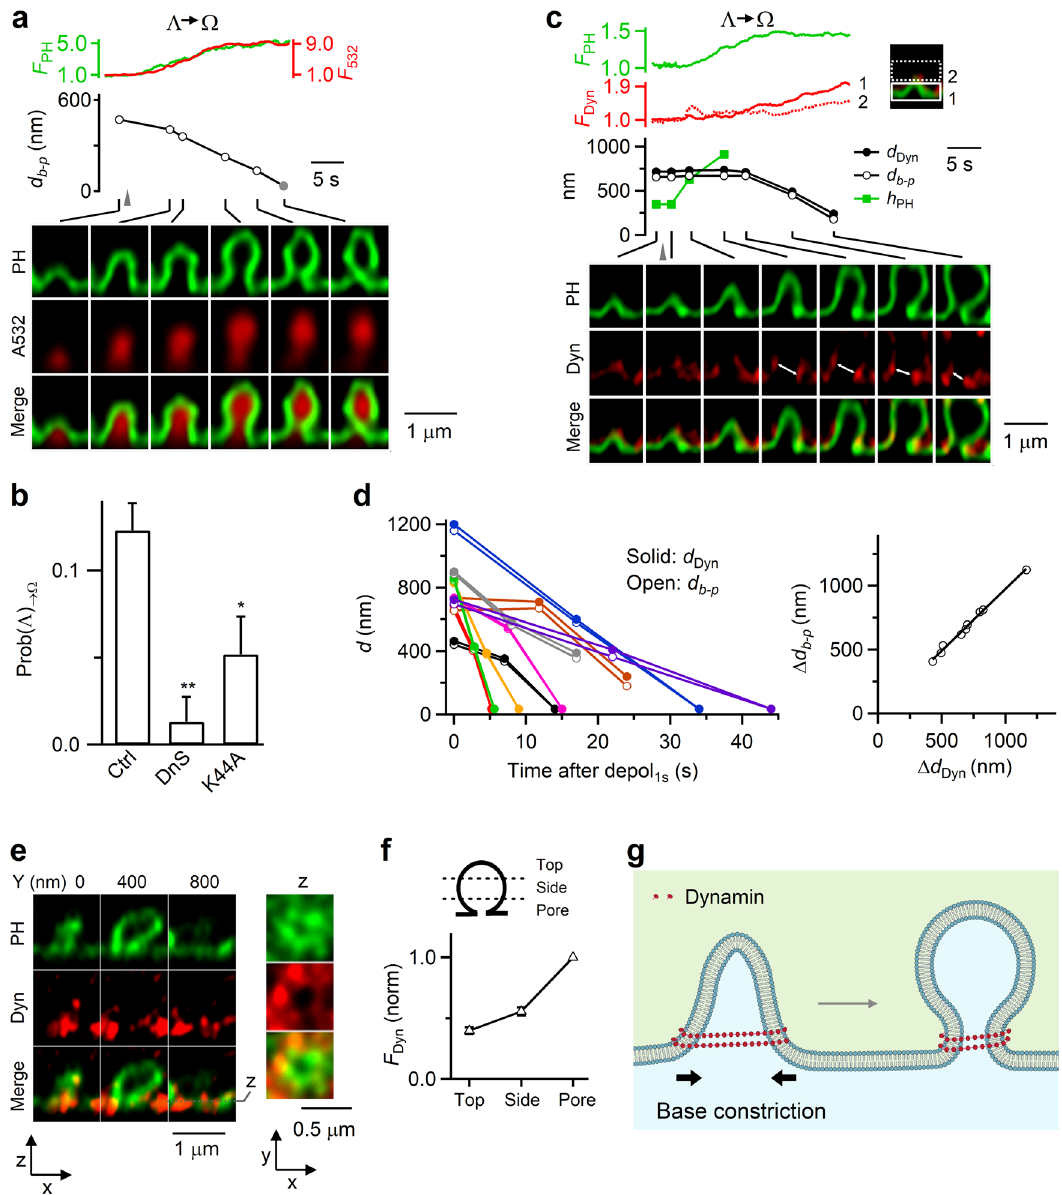
Fig. 4 Dynamin mediates Λ → Ω by surrounding and constricting Λ ’ s base in chromaf fi n cells. a F PH , F 532 , Λ ’ s base distance or Ω ’ s pore diameter ( d b-p ), and XZ/Y fi x images (at times indicated with lines) showing d b-p constriction during Λ → Ω . Gray triangle, depol 1s . Gray circle: <60 nm (STED resolution). b Inhibition of dynamin reduces Λ → Ω transition: Prob( Λ ) → Ω in control (Ctrl, 513 cells from 168 cultures; 336 bovines), in the presence of dynasore (DnS, 64 cells from 13 cultures; 26 bovines; p = 0.007), overexpressed dynamin 1-K44A (Dyn-K44A, 106 cells from 21 cultures; 42 bovines; p = 0.032). * p < 0.05; ** p < 0.01 (two-tailed unpaired t -test, compared to Ctrl). Data are presented as mean + SEM. c Dynamin puncta fl anked and moved with constricting Λ ’ s base and constricting Ω ’ s pore: F PH , F Dyn , Λ ’ s base distance or Ω ’ s pore diameter (d b-p ), the distance between two dynamin puncta fl anking Λ / Ω ’ s base/pore (d Λ → Ω transition. F Λ / Ω Dyn , double arrows), and sample XZ/Y fi x images of PH/dynamin for a Dyn (normalized) from region 1 (near base) and 2 (above base, inset) are plotted. d Left: d b-p and d Dyn ( d ) plotted versus time after depol 1s during Λ → Ω transition. Each color: one event (9 events). Right: the decrease of d b-p ( Δ d b-p ) plotted versus the decrease of d Dyn ( Δ d Dyn ) observed during Λ → Ω transition (each circle: one transition, 9 transitions). The line is a linear regression fi t. e Dynamin surrounds Ω ’ s pore region: XZ images of PH G and Dyn (dynamin 1-mTFP1) for a Ω p along Y-axis every 400nm as labeled; XY images at the Z-axis location, z (dotted line), are also shown. f F Dyn at the pore, side and top region of Ω (see drawings, 67 Ω ; from 17 cells, 4 cultures, 8 bovines). F Dyn is normalized (norm) to that at the pore region. g Schematic drawing: dynamin surrounds and constricts Λ ’ s base, converting Λ to Ω . Source data are provided as a Source Data fi